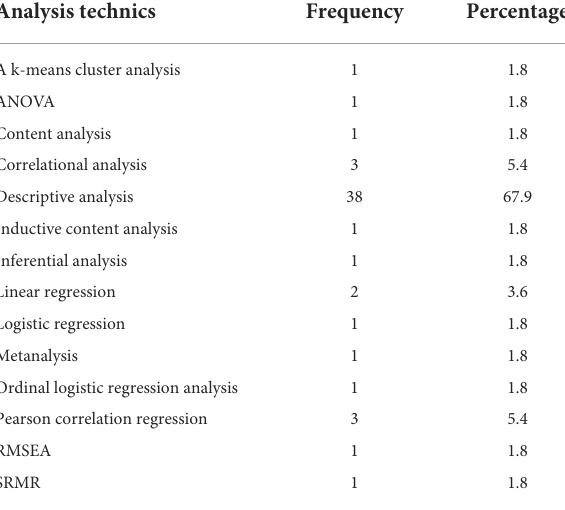
TABLE 5 Data analysis tools and techniques.